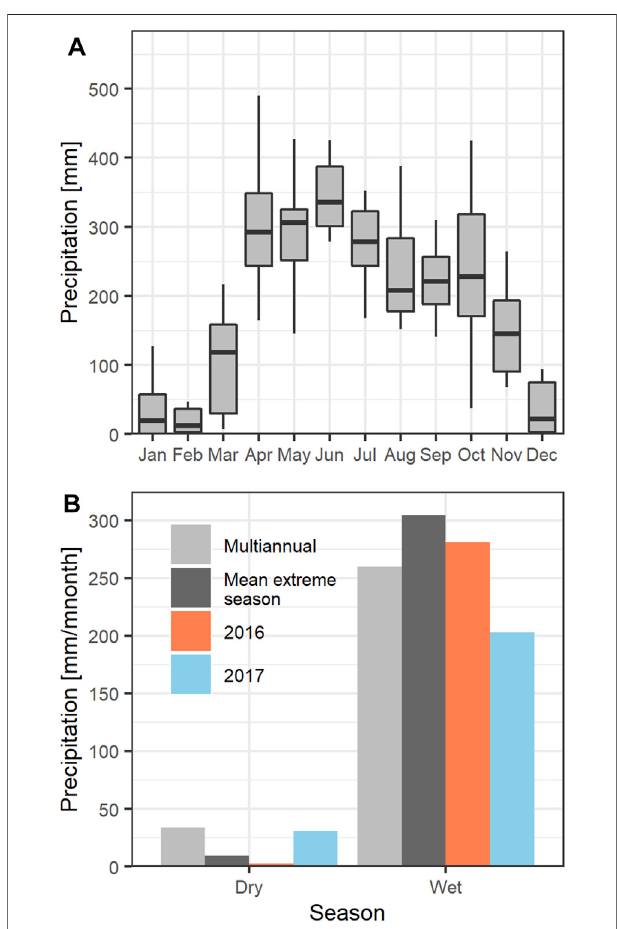
FIGURE2| Multiannualprecipitationpatternsfortheperiod2005 – 2020. (A) monthly precipitation and (B) comparison of precipitation during the dry (January and February) and wet seasons(April – November)for the multiannual period (2005 – 2020), the mean extreme season (de fi ned as the 5 years having the highest and lowest precipitation), and 2016 and 2017. December wasexcludedfromthedryseasontofocustheanalysisonthemiddleandend of the